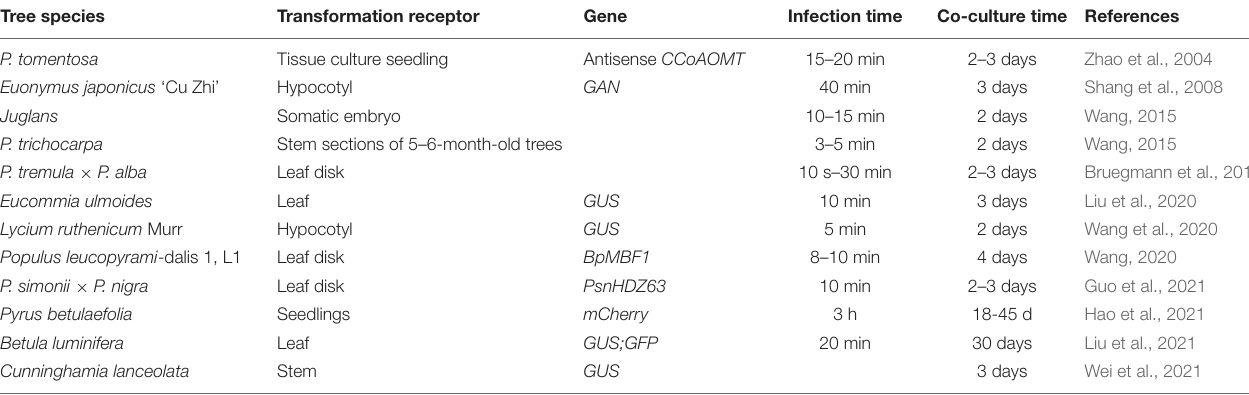
TABLE 2 | Infection time and coculture time of different trees. Tree species